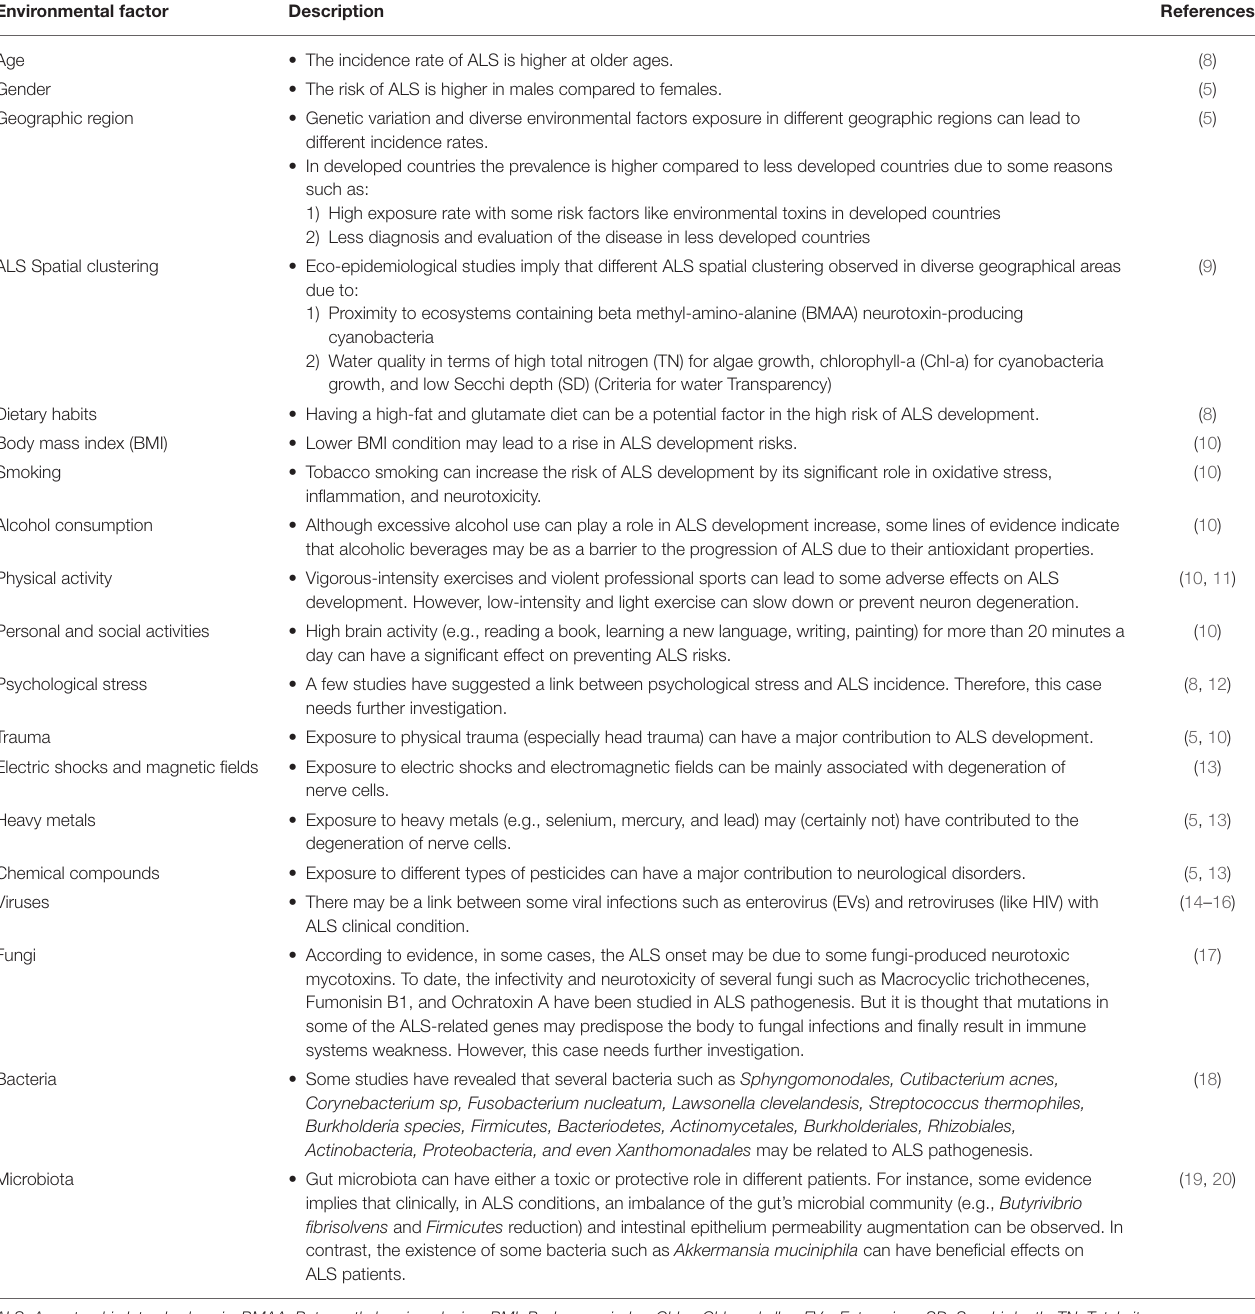
TABLE 1 | Environmental factors involved in ALS